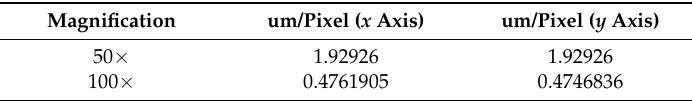
Table 3. Pixel size under specific magnification.